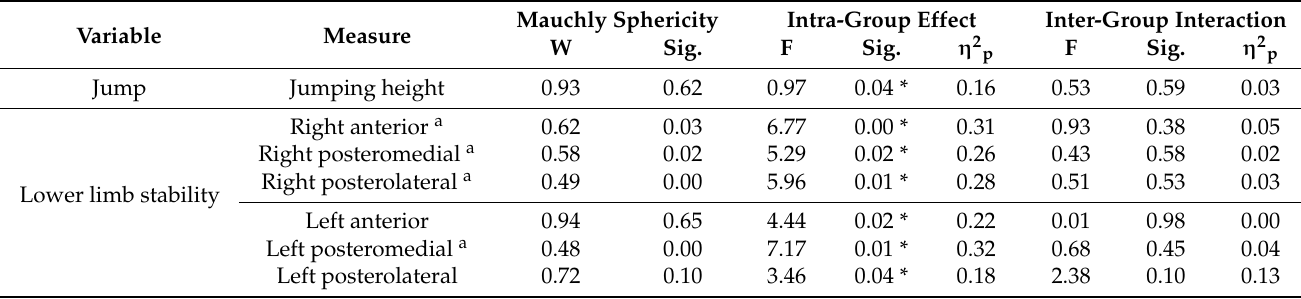
Table 4. Within-subject and group interaction results in each of the dependent variables of the study and for the study groups.